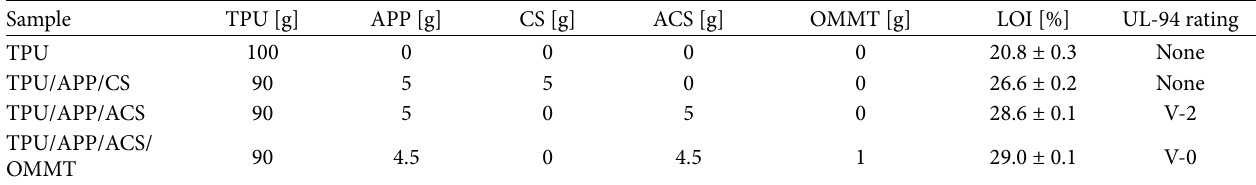
Table 1: Formulations and flammability test results of TPU composites [45].